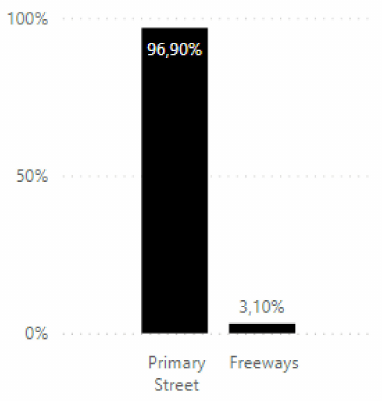
Figure 2. Traffic distribution by road type in Lisbon in 2019.